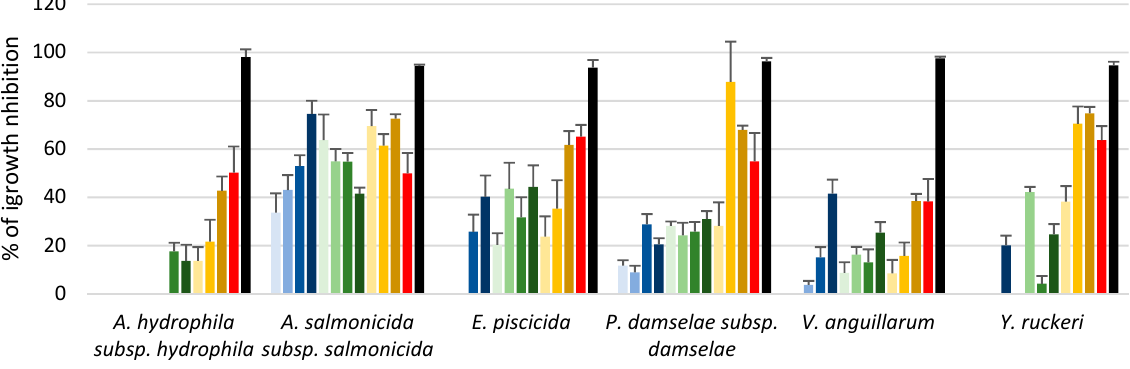
Figure 7. Growth inhibition (%) of fish pathogenic bacteria in the presence of aqueous extract of G. gracilis in liquid media after 18 h of growth. The extracts were obtained at room temperature (RT, bars in shades of blue), 40 °C (40, bars in shades of green), or 70 °C (70, bars in shades of yellow/red) for 30 min, and chloramphenicol (CHL, black bars) was used as a positive control. Results are expressed as average values ± SD ( n = 4).